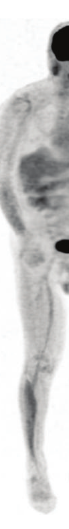
Figure 1: PET scan obtained to evaluate and stage the extent of histologically confirmed local recurrence of left lower leg soft tissue